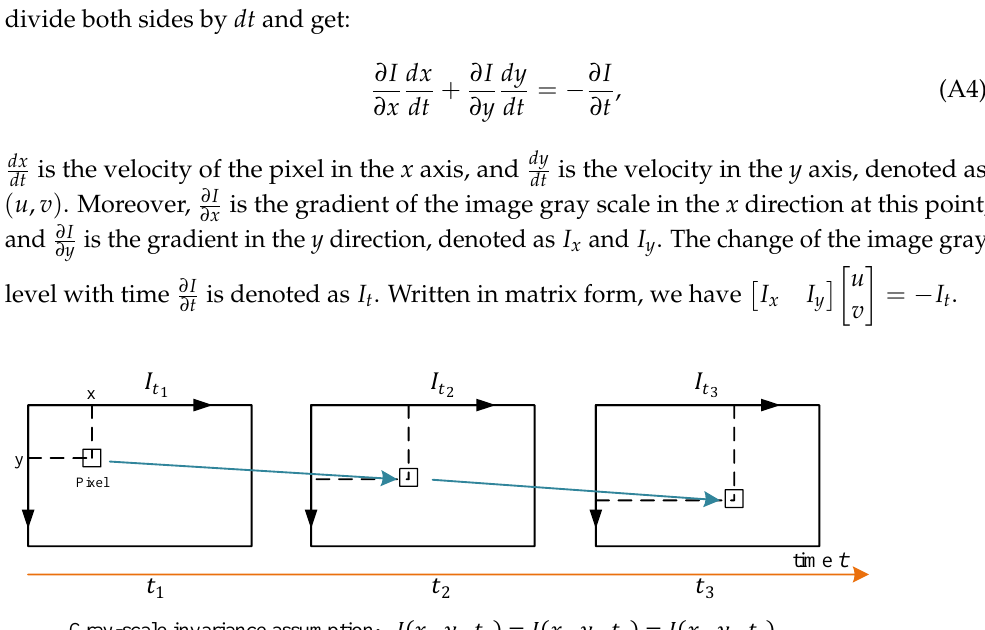
denote the image data at time t i , x and y i